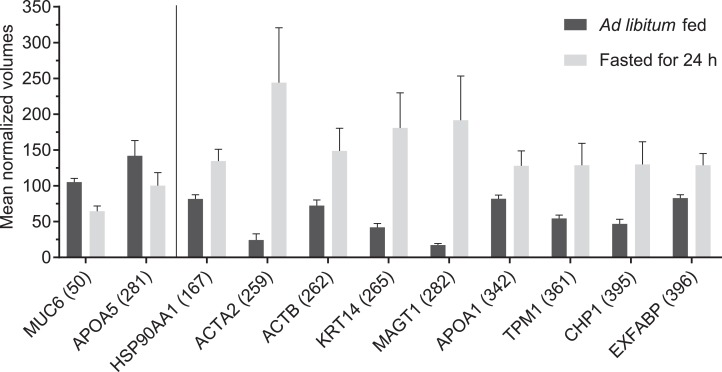
Mean normalized volumes of significantly (P < 0.05) differentially expressed, successfully identified spots.Data are presented as group means, error bars represents ± SEM (with n = 8 in each group). The vertical line separates between downregulated (left) and upregulated (right) protein spots compared to the ad libitum fed group.